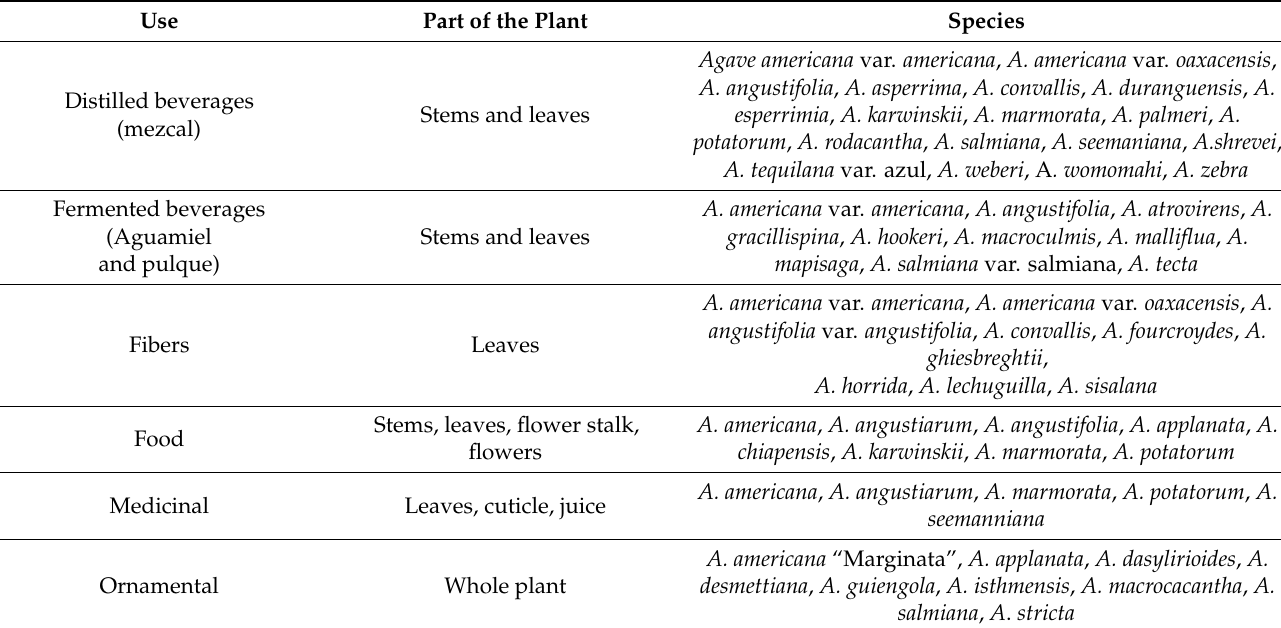
Table 1. Some uses of Agave species since pre-Hispanic times (modified from